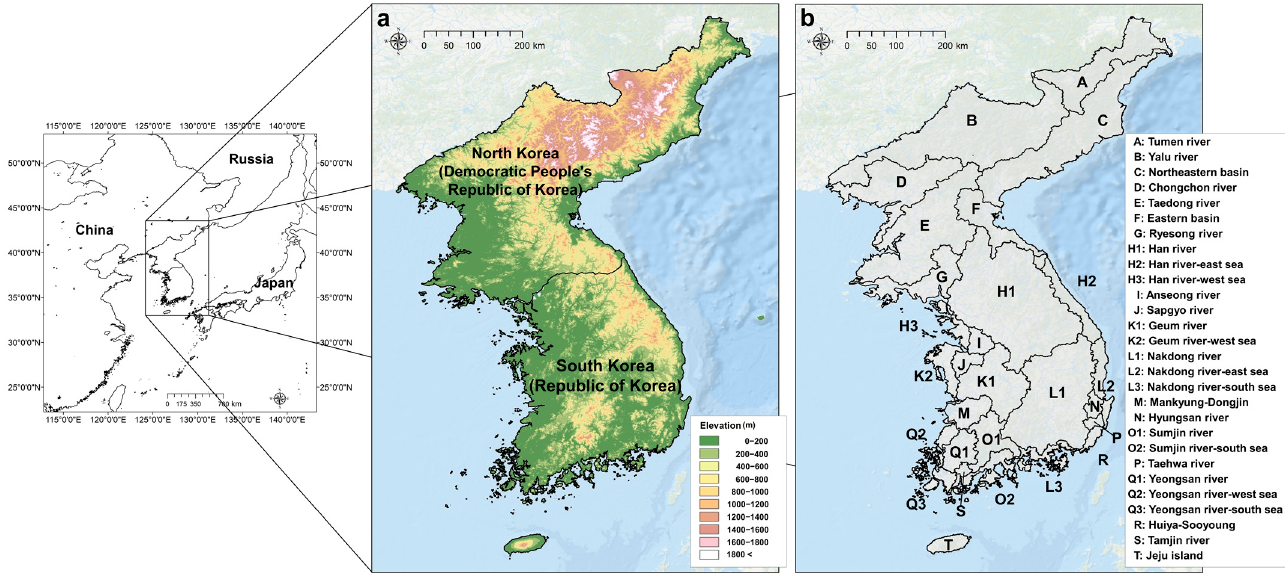
Figure 1. Basic spatial information of the Korean Peninsula: ( a ) national boundary with elevation and ( b ) major watershed map.